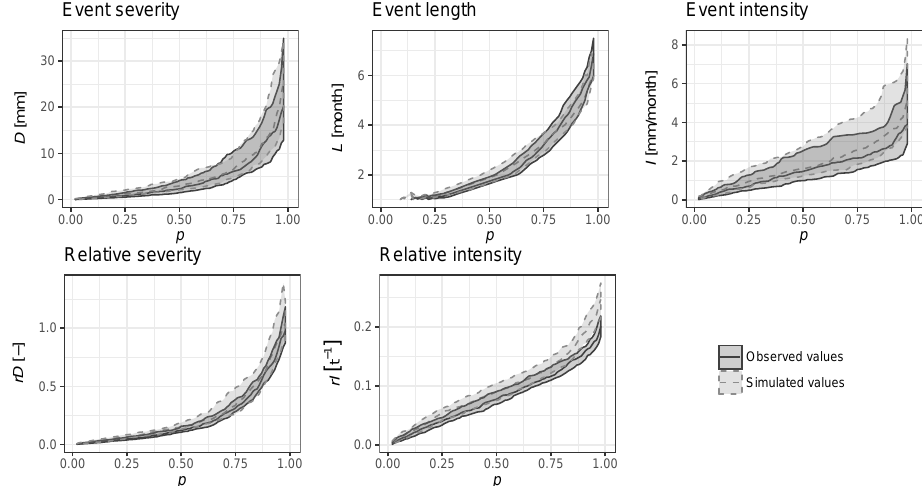
Figure 2. Comparison of drought characteristics for observed and simulated runoff. The empirical quantiles of the individual characteristics are indicated on the horizontal axis, the vertical axis shows values of drought characteristics, the polygons correspond to interquartile